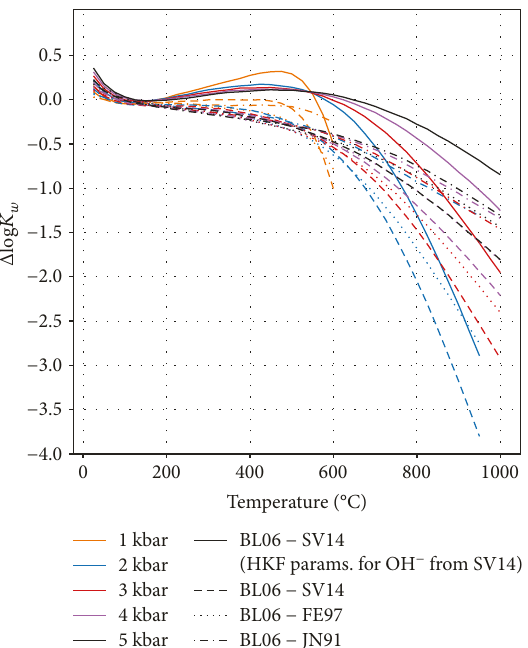
Figure 7: Di ff erences in calculated water dissociation constants from values obtained with the empirical model of Bandura and Lvov [83] (BL06) and values obtained from using SV14, FE97, and JN91 electrostatic models for calculating the standard state properties of OH − . The Gibbs energy of H O was calculated using 2 the IAPWS95 thermodynamic model. Full lines — di ff erences between BL06 and the SV14 electrostatic model using the nonsolvation HKF parameters reported by Sverjensky et al. [9]. The remaining di ff erences are obtained using the nonsolvation HKF parameters reported by Tanger and Helgeson [35]. Dashed lines — di ff erences between BL06 and SV14. Dotted lines — between BL06 and FE97. Dashed-dotted lines — between BL06 and